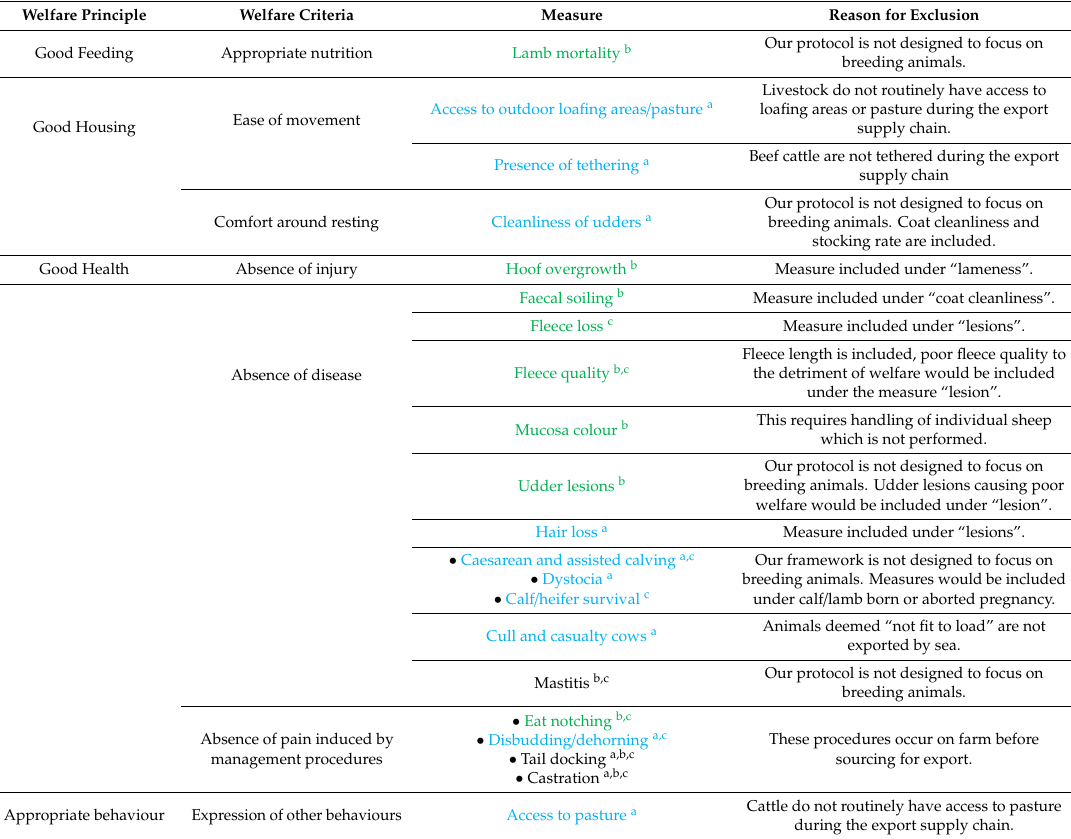
Table 3. Welfare measures from existing protocols for cattle and sheep that were not included within proposed export protocol. Colour indicates measures that are species specific; blue—cattle only measures, green—sheep only measures, and black—applicable to both